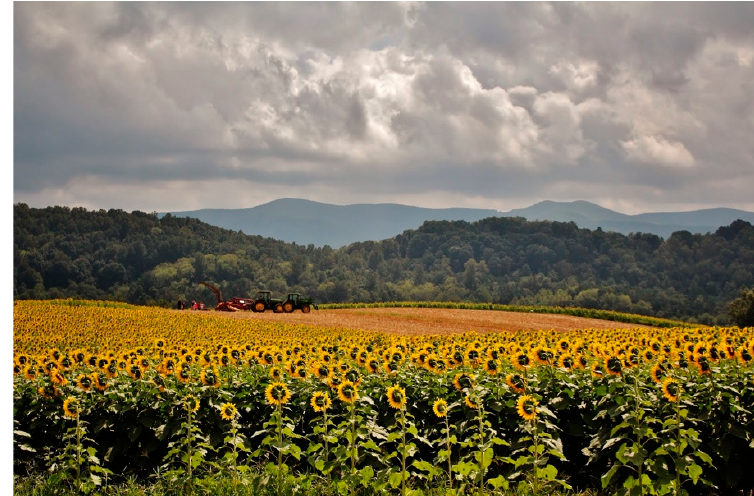
Figure 9. The sunflowers in this image contribute deep meaning about seasonality and the repro- ductive aspects of nature, as well as the human agricultural activities that produced this landscape. This landscape will occur reasonably often and is predictable. (Titled “Beaver Dam Farm” by Sandra Deans, courtesy of Scenic Virginia.)